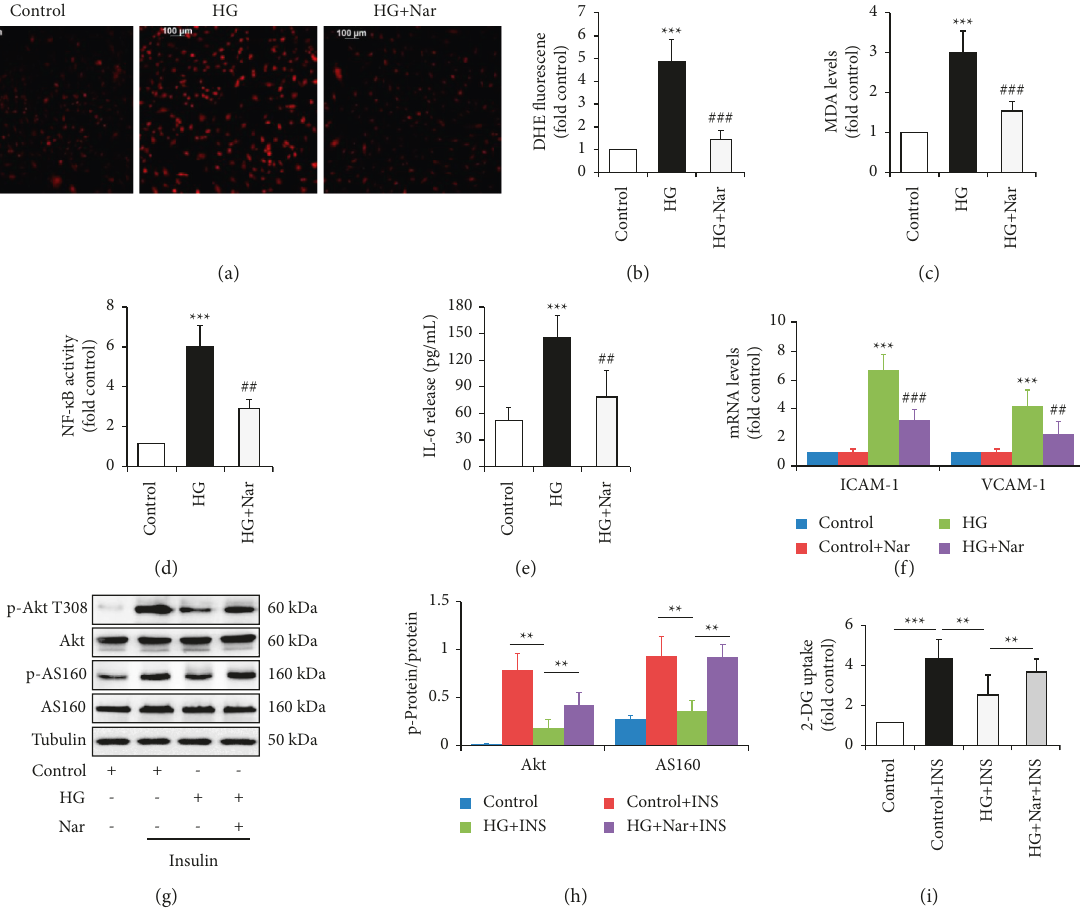
Figure 2: Effect of Nar on HG-induced alterations of endothelial function. HUVECs were exposed to NG (5.5mM glucose) or HG (30 mM glucose) media with or without the 50mM of Nar for 36h. To observe the effect of Nar on insulin signaling, the cells were treated with or without 100nM of insulin for 10 min. (a) Effect of Nar on ROS formation by DHE staining. (b) Quantification of relative DHE fluorescence in (a). (c) Effect of Nar on intracellular MDA concentration. (d) Effect of Nar on NF- κ B activity. (e) Effect of Nar on IL-6 concentration in the culture media. (f) Effect of Nar on mRNA levels of cell adhesion molecules ICAM-1 and VCAM-1. (g) Effect of Nar on insulin- stimulated phosphorylation of Akt and its downstream AS160. (h) Quantification of phosphorylated Akt and AS160 in (g). (i) Effect of Nar on insulin-stimulated 2-DG uptake. Data are expressed as means ± SD ( n � 3). ∗∗ P < 0 . 01 and ∗∗∗ P < 0 . 001 versus control (NG) group or the indicated group. ## P < 0 . 01 and ### P < 0 . 001 versus high-glucose (HG)